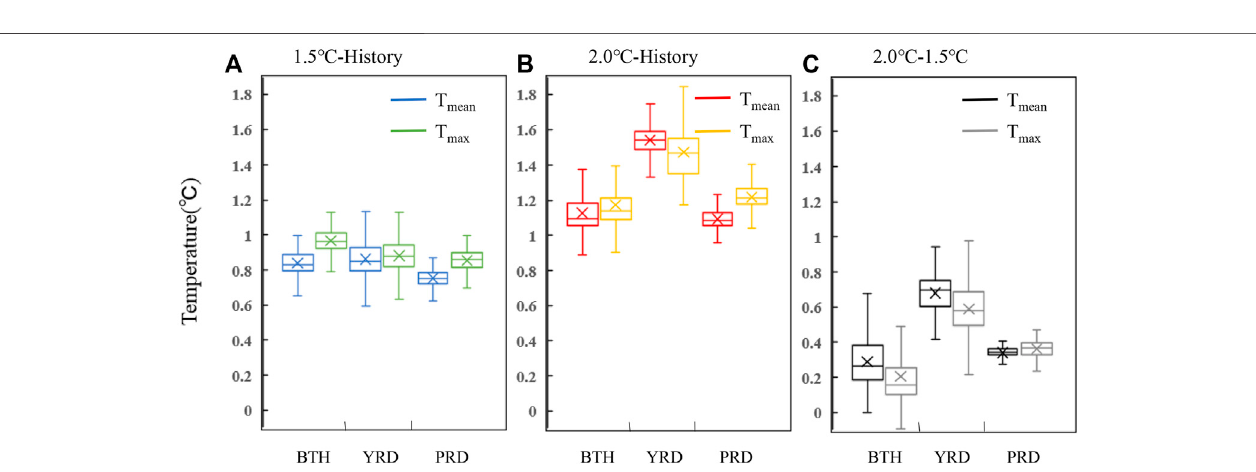
FIGURE 5 | Box diagram of the differences in T mean and T max of the three urban agglomerations over eastern China between (A) Exp 1.5-run and Exp HIS-run, between (B) Exp2.0-runandExpHIS-run,andbetween (C) Exp2.0-runandExp1.5-run( “ × ” representstheaveragevalue,thetophorizontallinereferstothemaximum value,thebottom horizontal linerepresentstheminimumvalue,theupperand lowerquartileindicate theranges from25thto75thpercentile inthepackingdrawing,and the middle horizontal line represents the median).